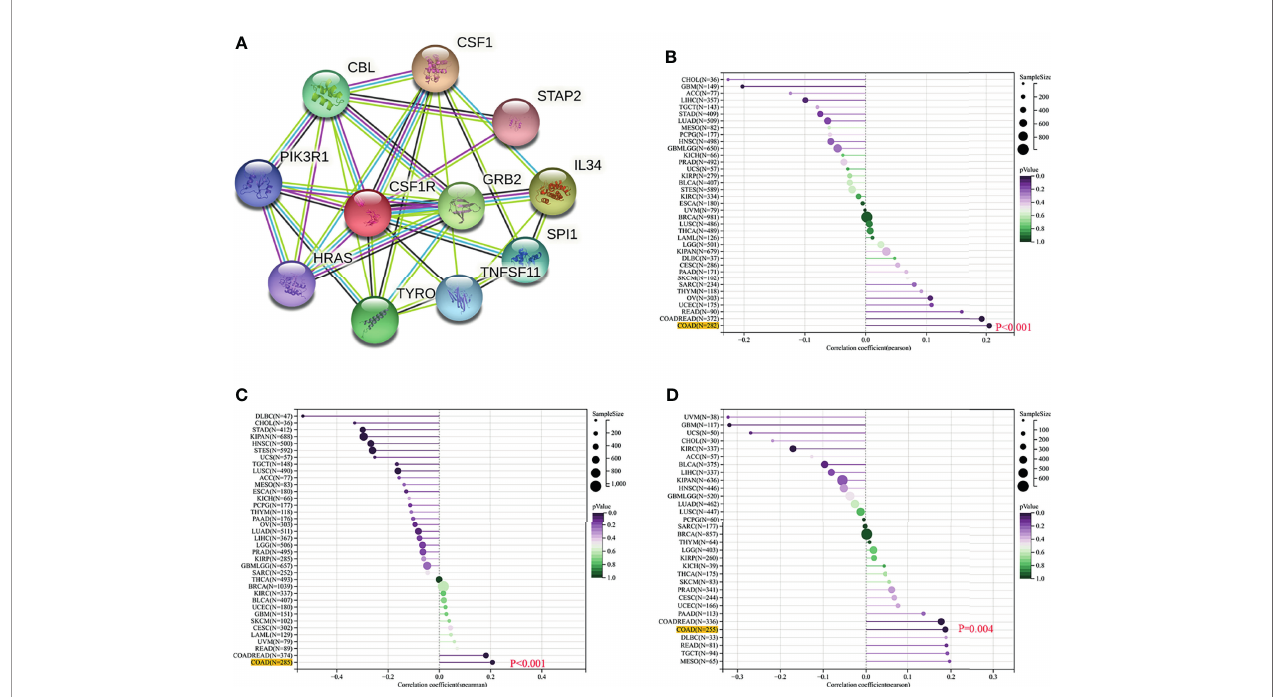
FIGURE 6 | Value of CSF-1R in predicting the response to COAD immunotherapy. (A) PPI network based on CSF-1R expression. (B) Associations between CSF- 1R expression and TMB. (C) Associations between CSF-1R expression and MSI. (D) Associations between CSF-1R expression and